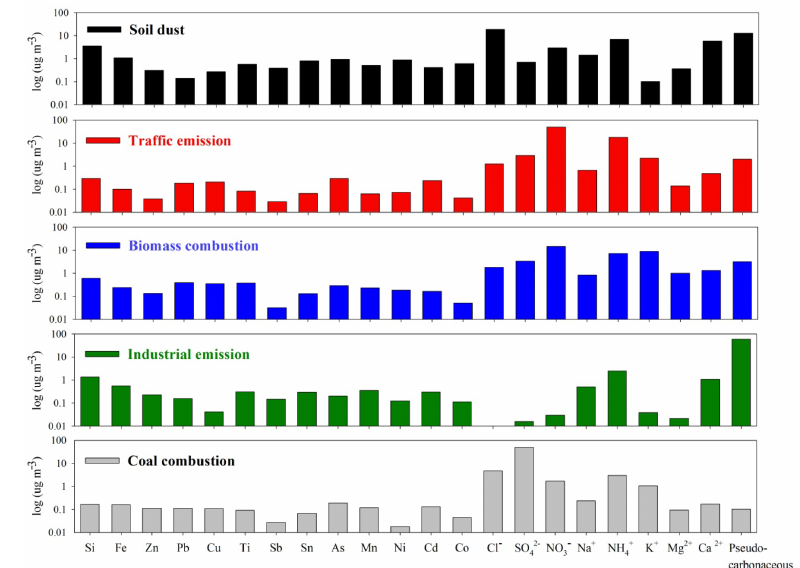
Figure 3. Composition profiles of the five factors identified in NMF